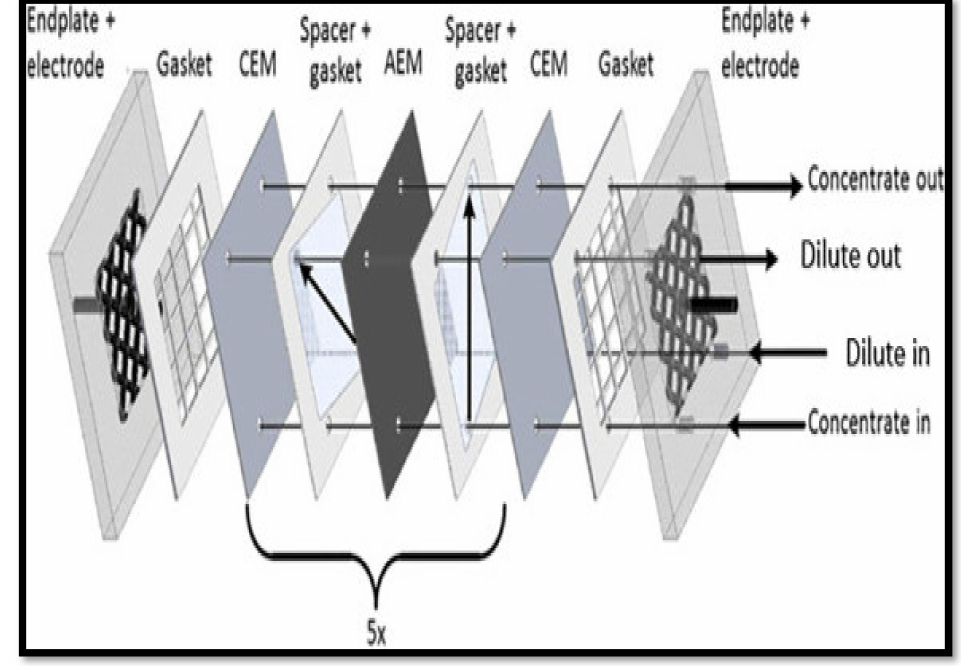
Figure 13. Electrodialysis stack with five cell pairs of AEM CEM [101], with permission from